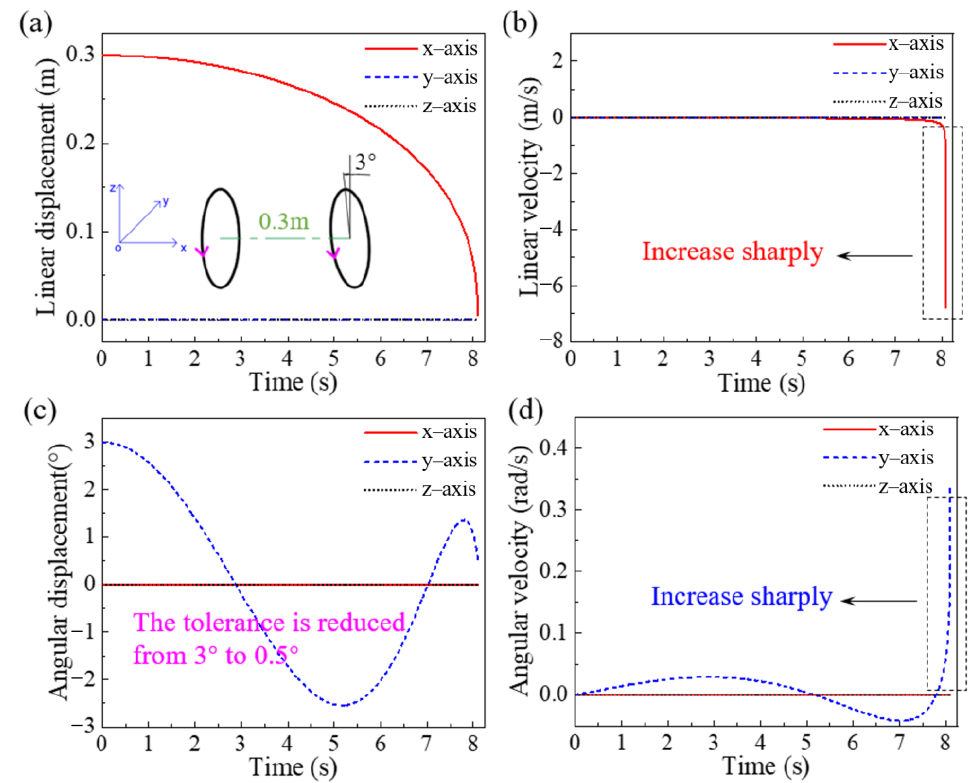
Figure 6. The linear displacement ( a ), linear velocity ( b ), angular displacement ( c ), and angular velocity ( d ) of the subsatellite during the docking process with a tolerance of 3°.